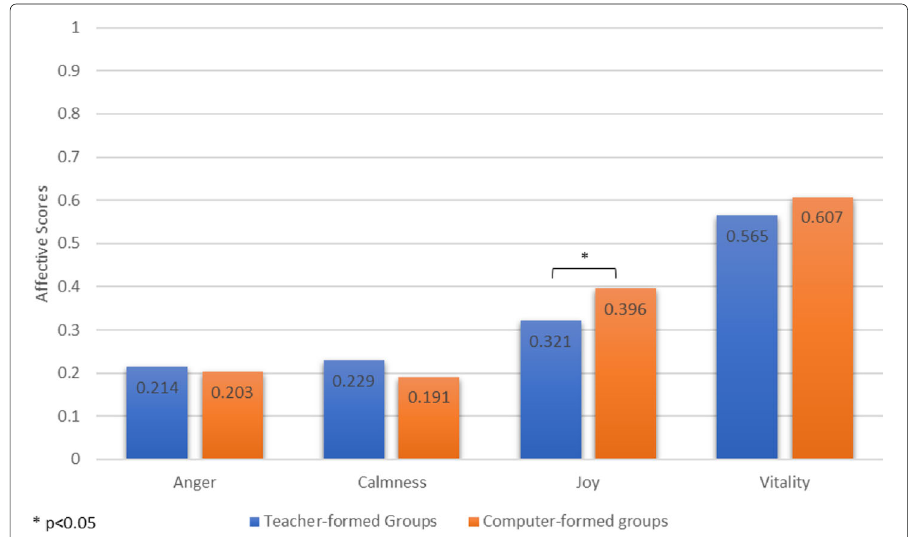
Fig. 13 Difference in affective state scores for knowledge exchange